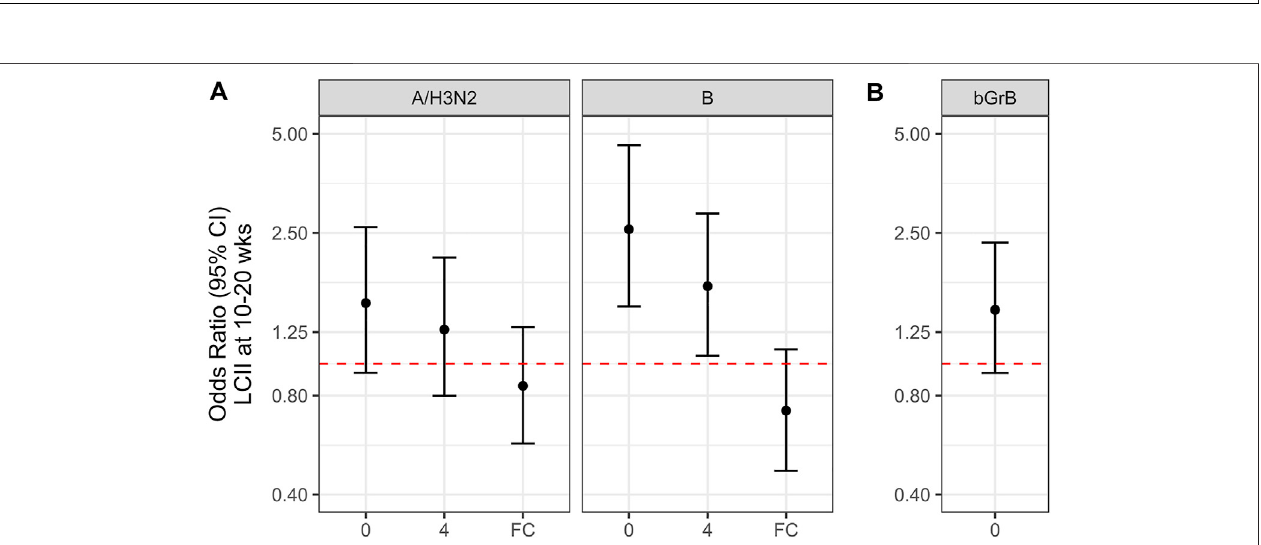
FIGURE3| Thelikelihoodoflaboratorycon fi rmedin fl uenzaillness(LCII)at10 – 20weekspost-vaccination, (A), relativeto exvivo granzymeB(GrB)activity,and (B), basal GrB (bGrB) activity in circulating T cells. The odds ratio (OR) and 95% con fi dence interval for being LCII positive per 1-standard deviation in the natural-log of each measure at pre-vaccination (0-weeks) or 4-weeks post-vaccination or the natural-log fold-change (FC) pre-to 4-weeks. For both A and B , activity estimates for participants that developed A/H3N2 LCII A (left panel) were based on ex vivo stimulation with A/Victoria (H3N2) virus, whereas estimates for participants that developed B-LCII A (right panel) were based on ex vivo stimulation with B/Lee virus; the corresponding estimates for No-LCII participants from A/Victoria (H3N2) stimulation A(leftpanel) andfromB/Leestimulation A(rightpanel) wereusedtocalculatetheOR.Overlapbetweenthecon fi denceintervalandthered,dashedline(ie. OR (cid:1) 1) indicates that the odds ratio is not statistically signi fi cant.